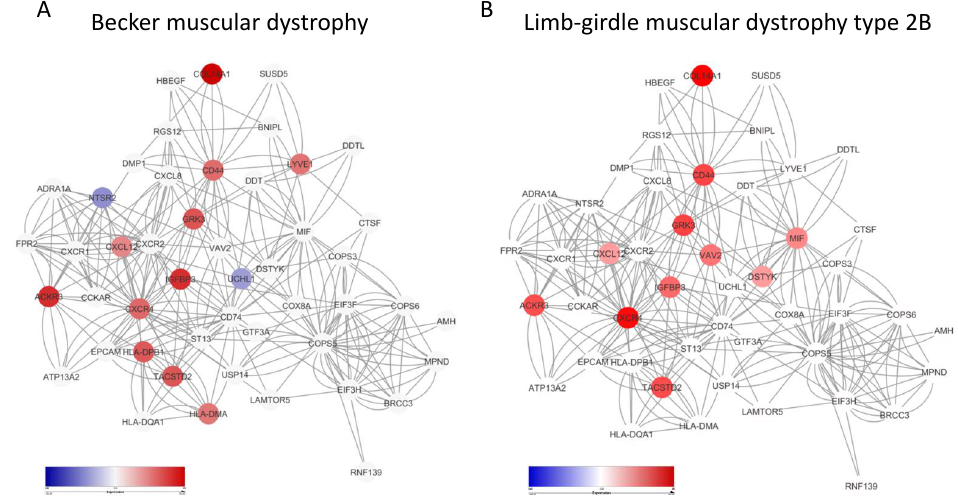
Figure 2. MIF network in dystrophic muscle diseases. MIF network showing DEGs as nodes color-coded based on fold change, in Becker ’s disease ( A ) and in limb-girdle muscular dystrophy type 2B ( B ), as determined in the GSE79263 dataset.